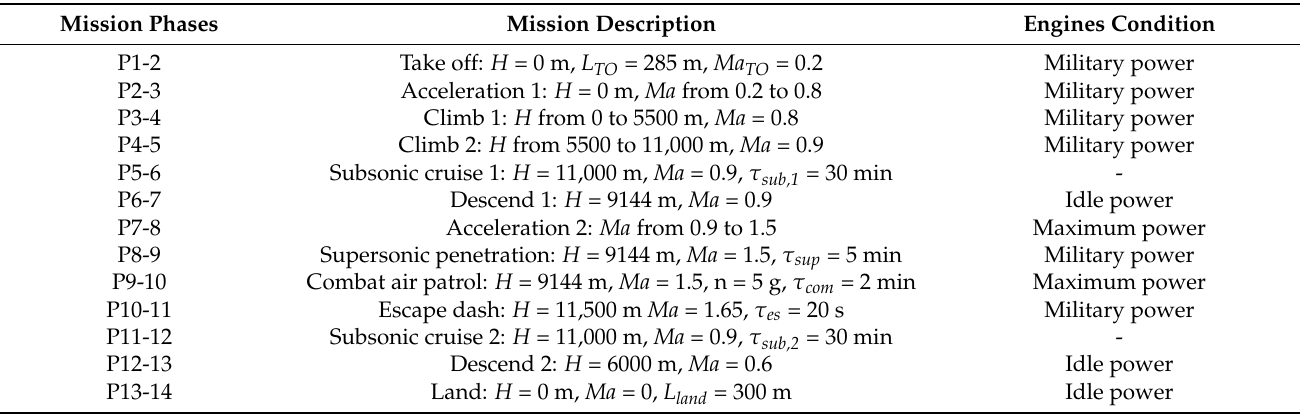
Figure 3. Schematic of a typical flight mission of advanced fighter. Table 2. A typical flight phase of advanced